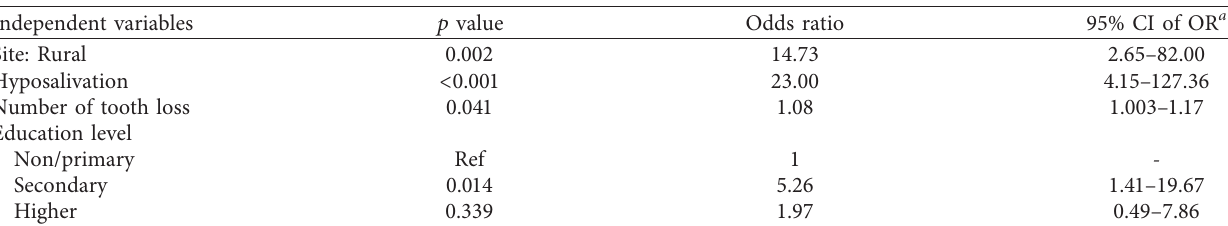
Table 4: Results from a study of prevalence and risk factors of high-level oral microbe using binary logistic regression analysis [21]. Independent